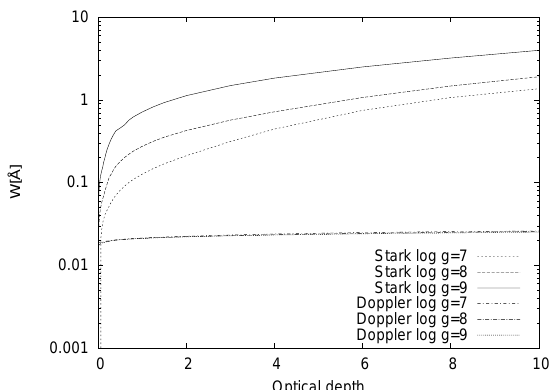
Fig. 4. Thermal Doppler and Stark widths for Se III spectral line 5s 3 P o { 5p 3 D ( (cid:21) = 3815.5 (cid:23)A) for a model of the DB white dwarf atmosphere with T eff = 15 000 K and 7 (cid:20) log g (cid:20) 9, as a function of the optical depth (cid:28) 5150 . (SerVO, http://www.servo.aob.rs/ (cid:24) darko, P.I. Darko Jevremovi´c). The main